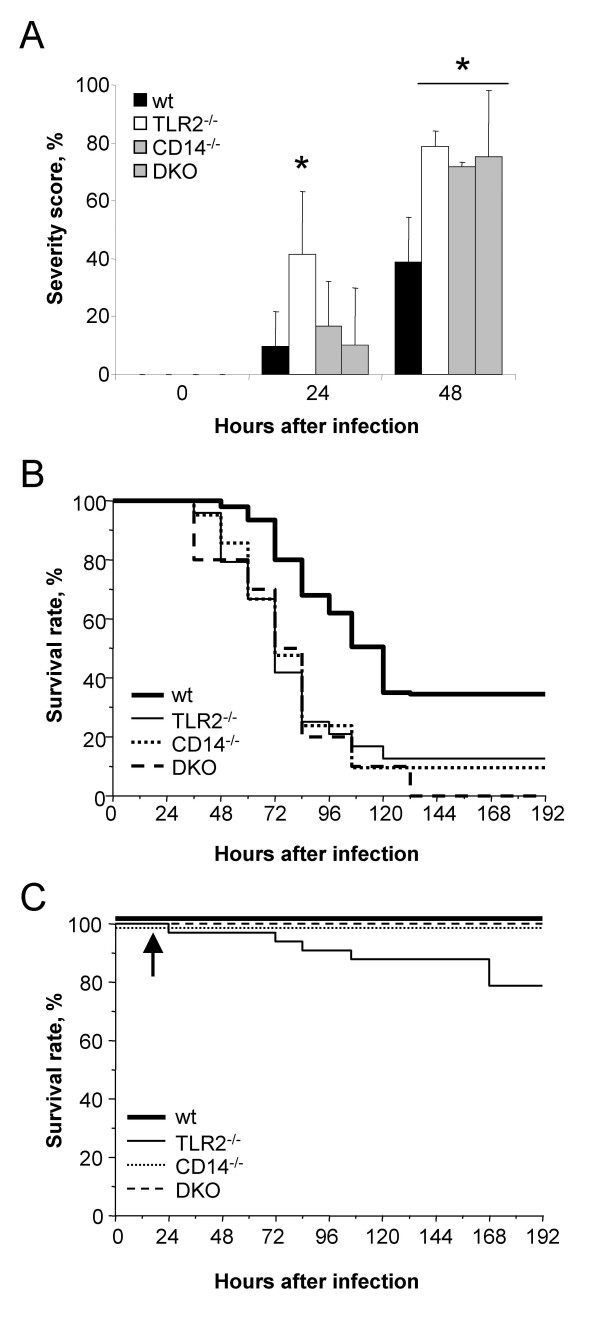
A) Percentage of wt (n = 40), TLR2-/-(n = 35), CD14-/- (n = 29) and TLR2-/-/CD14-/- (n = 31) mice showing high severity score (including score higher than 2.5) after infection with S. pneumoniae. Mean ± SD of four independent experiments (p < 0.02, ANOVA). B) Mortality from untreated pneumococcal meningitis: wt (n = 33), TLR2-/- (n = 24), CD14-/- (n = 21) and TLR2-/-/CD14-/- (n = 10) mice. C) Effect of antibiotic treatment in wt (n = 15), TLR2-/- (n = 15), CD14-/- (n = 9) and TLR2-/-/CD14-/- (n = 9) mice. Arrow indicates start of ceftriaxone therapy.